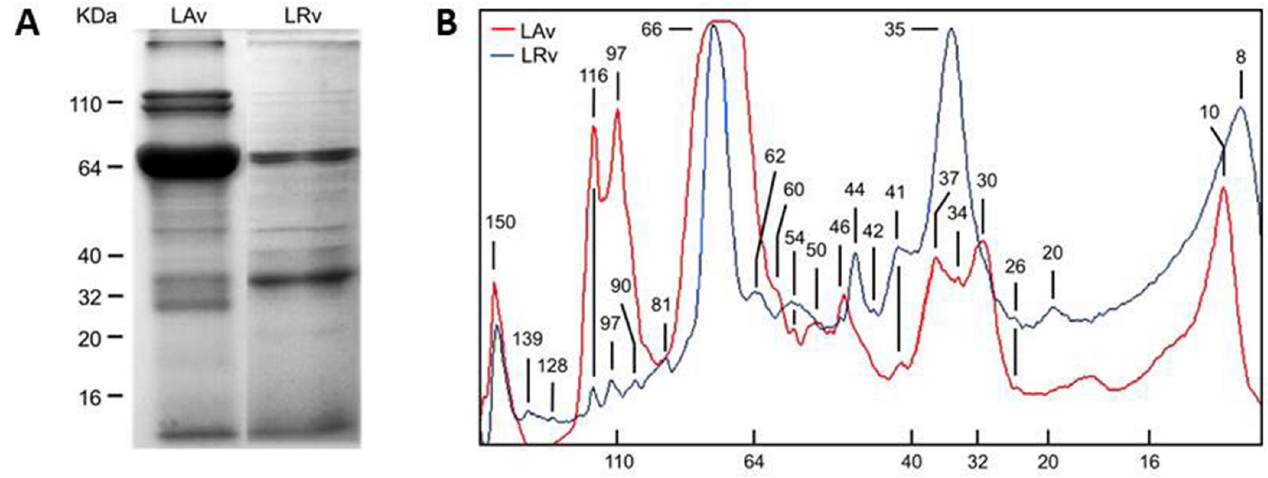
Fig 1. Protein molecular weight pattern of L . apachea and L . reclusa venoms. (A) 12% SDS-PAGE of 24 μ g L . apachea (LAv) and L . reclusa (LRv) venoms; (B) LAv and LRv SDS-PAGE densitometry, the molecular weight of each SDS-PAGE band was identified. LAv is plotted in red line and LRv in blue line. Molecular weight markers are shown on the left in A and in the bottom in